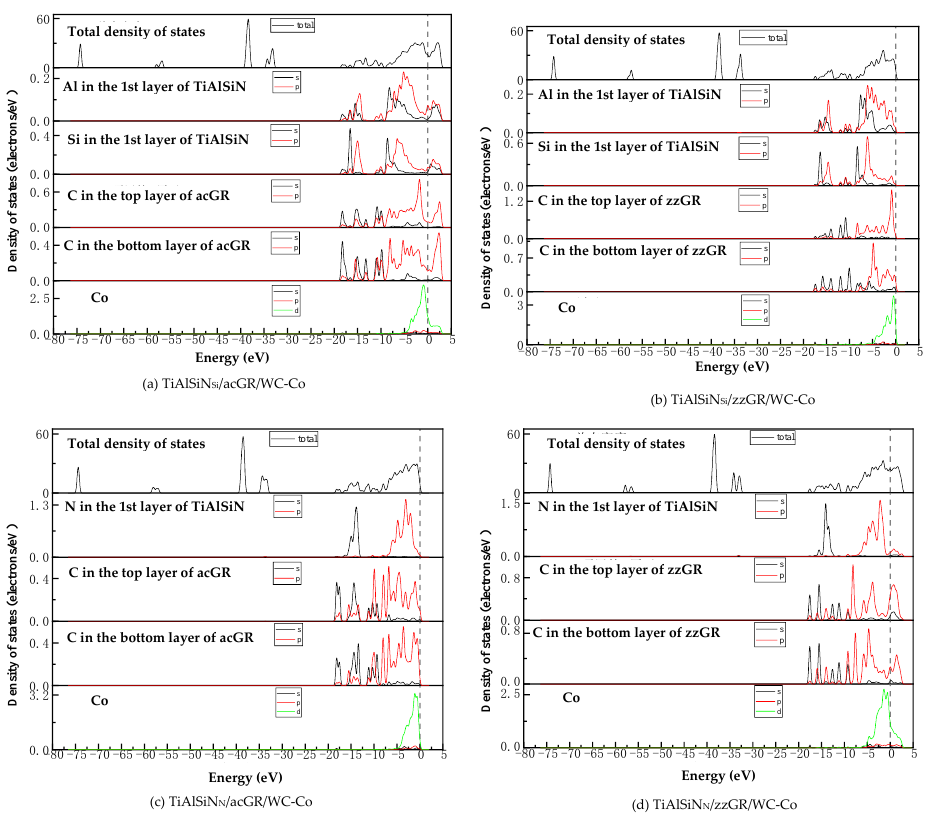
Figure 22. TDOS and PDOS of the interface models with the coating/matrix interface doped with an intrinsic graphene boundary.